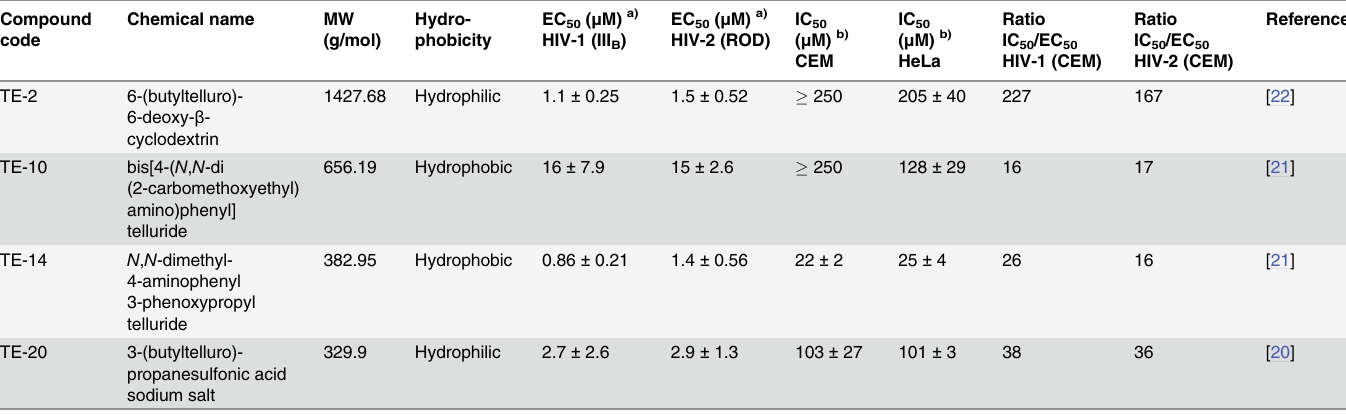
Table 1. Anti-HIV and cytostatic activities of organotellurium compounds in CEM and HeLa cell cultures. Compound code